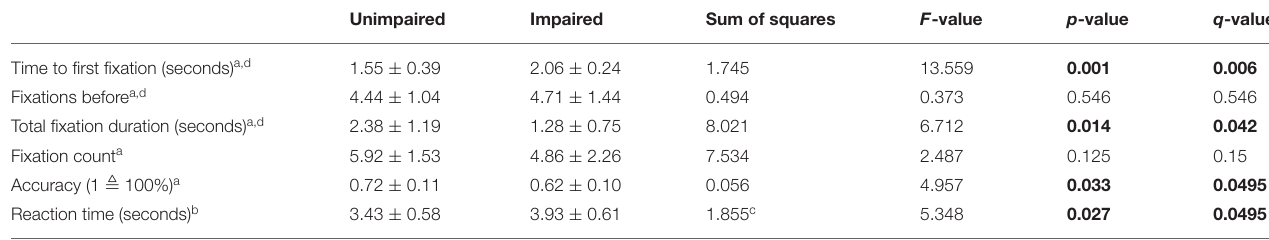
TABLE 2 | Visual search behavior depending on SDMT. Unimpaired Impaired Sum of squares F -value q -value